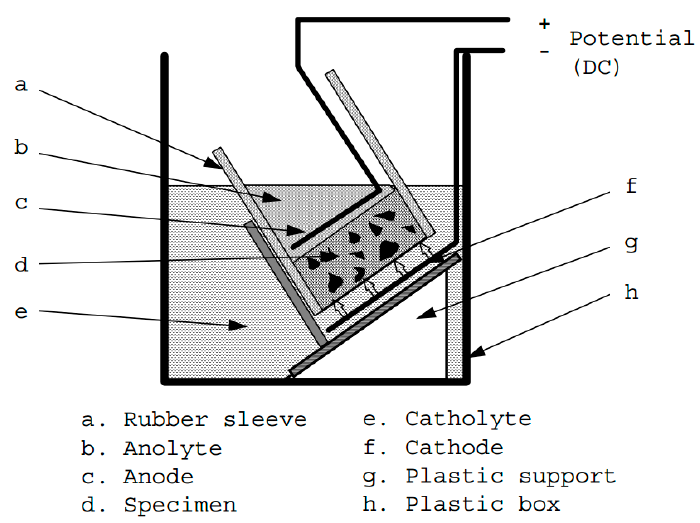
Figure 1. Test setup for chloride migration test [14].